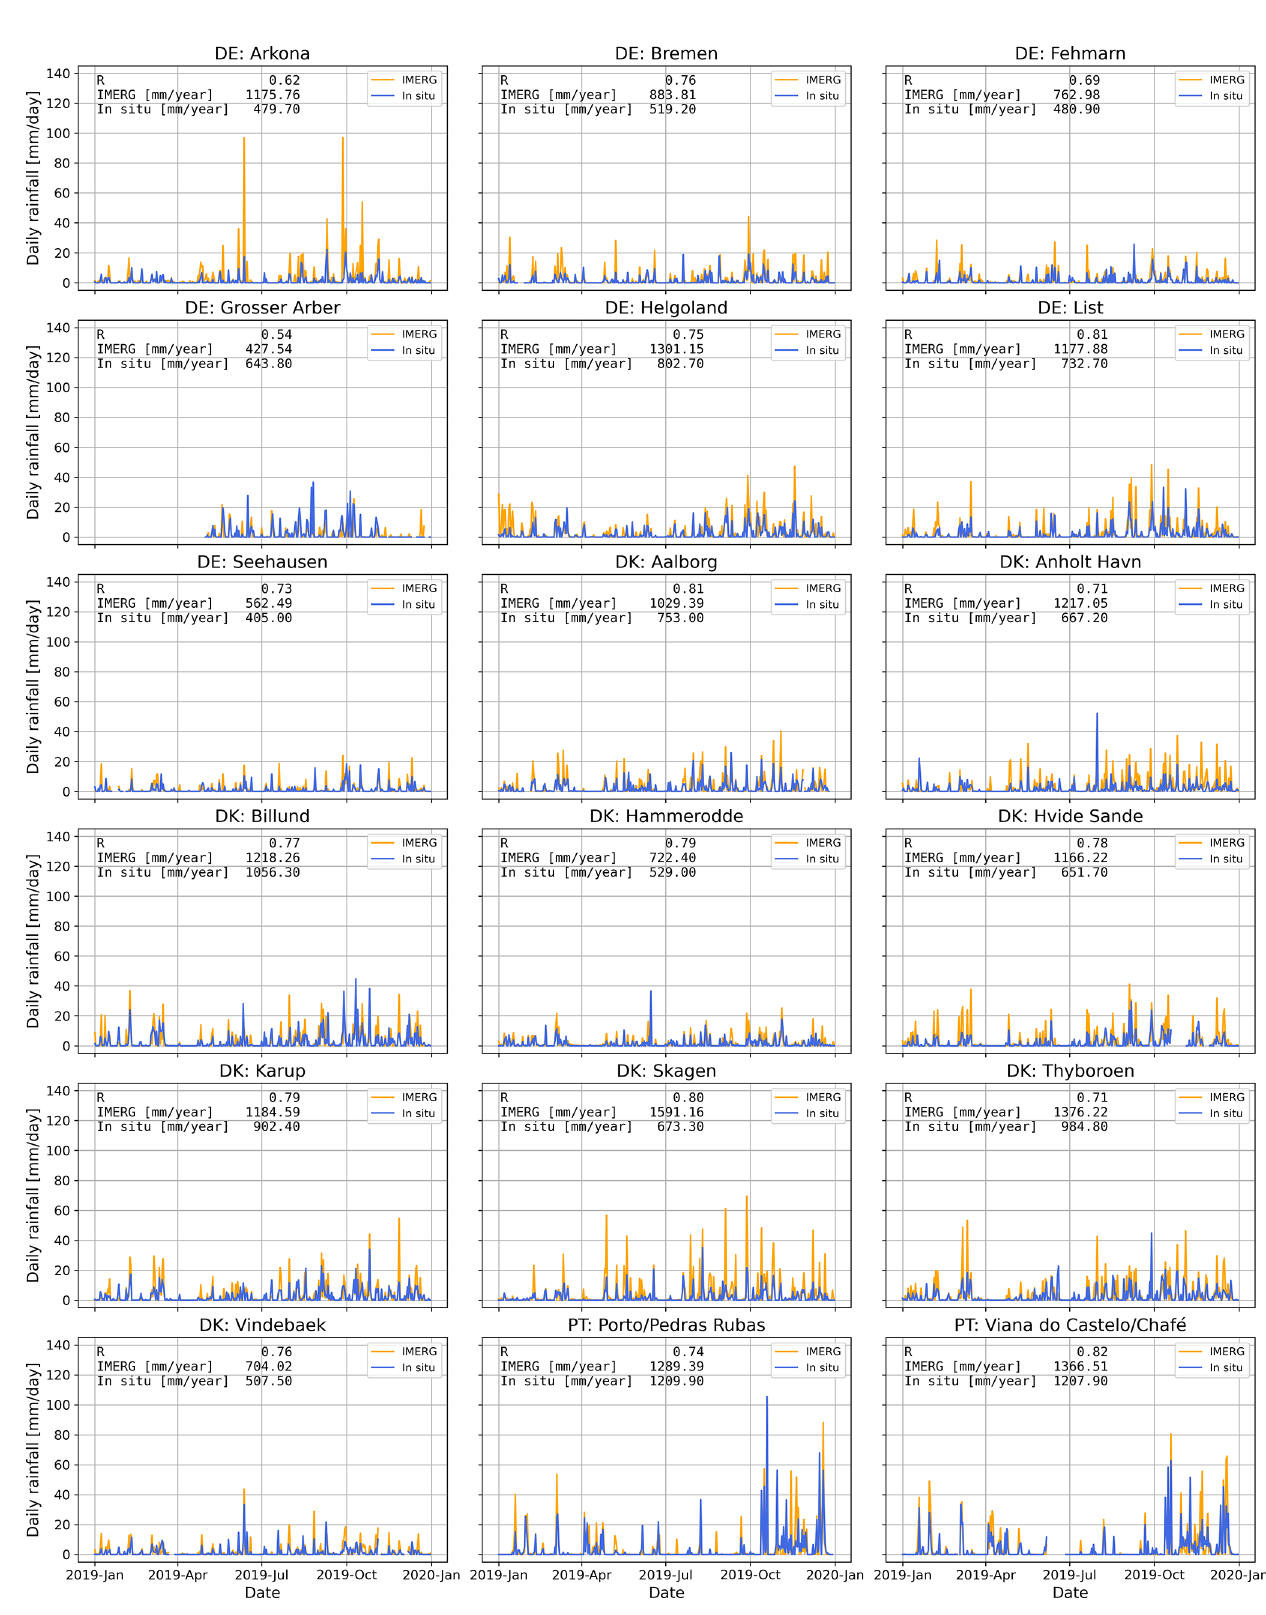
Figure 5. Daily rainfall intensities from IMERG and in situ observations during the example year 2019 for the 18 stations investigated.